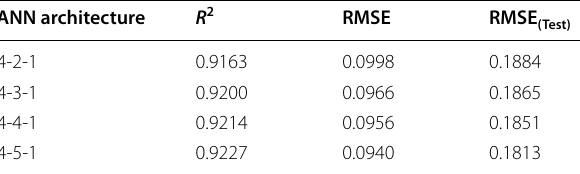
Table 5 Statistical results of different ANN model